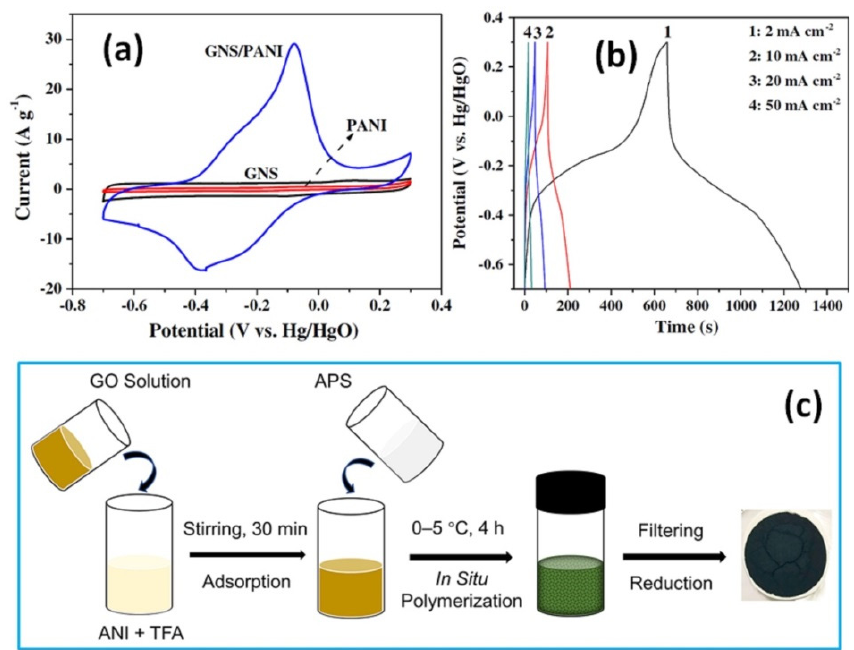
Figure 6. CV curves of GNS, pristine PANI and GNS/PANI composite at 10 mV/s ( a ) and GCD tests of GNS/PANI composite within the potential window − 0.7 to 0.3 V (vs. Hg/HgO) at different current densities of 2, 10, 20 and 50 mA/cm 2 ( b ) (Reprinted from [86], Copyright 2010, with permission from Elsevier). Schematic diagram of the synthesis of RGO/PANI composites ( c ) (Reprinted with permission from [85]. Copyright 2020 American Chemical Society).